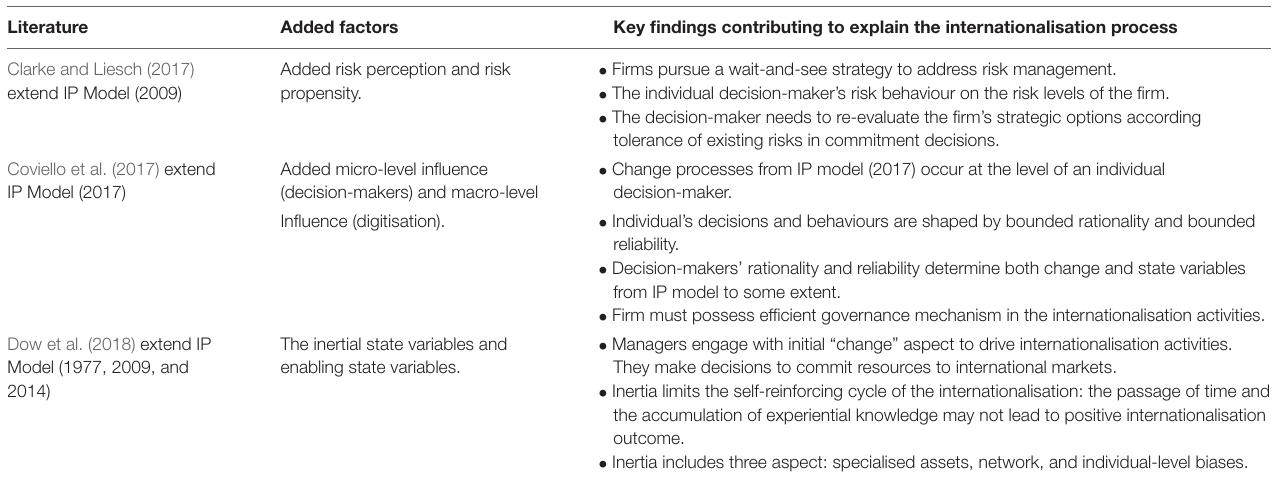
TABLE 2 | Extensions to the process of internationalisation (IP) model. Added